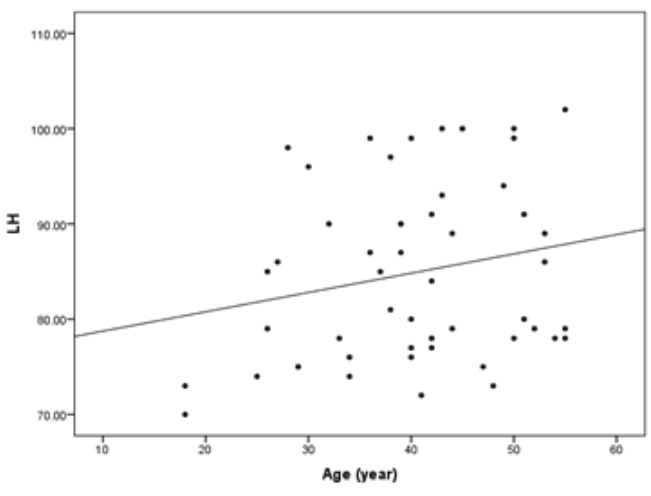
Figure 4 : Correlation of age with LH in case group ( R = 0.387, P = 0.000).